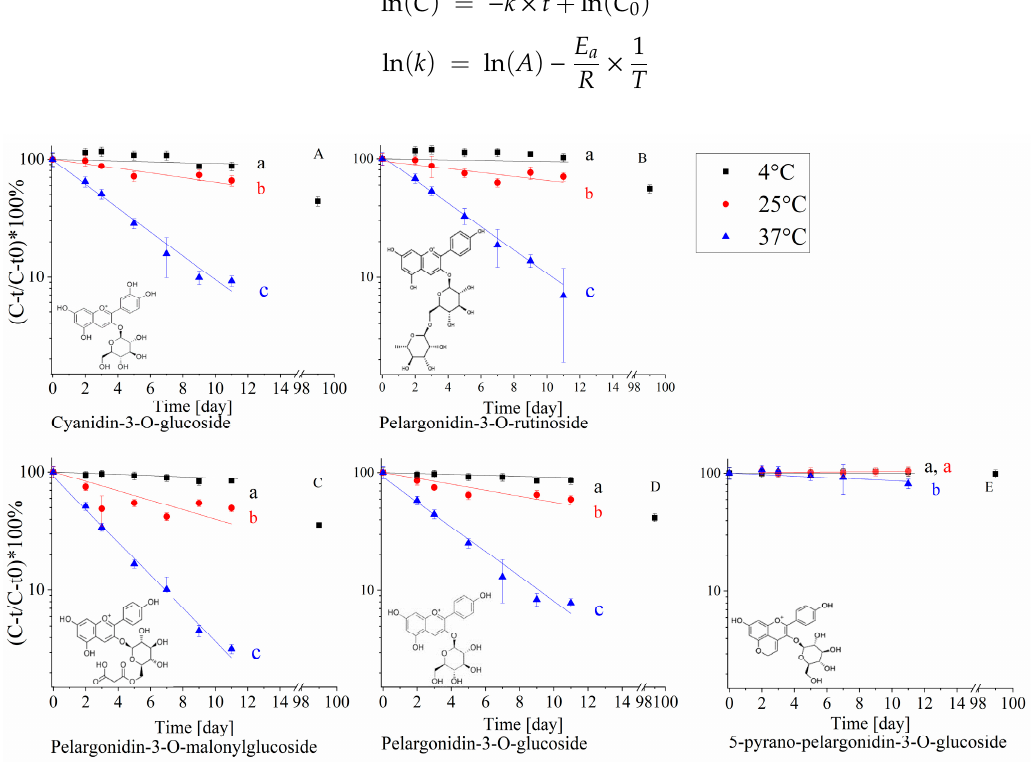
Figure 3. Relative concentration (quantified by HPLC at 520 nm) of the anthocyanins in the extract during shelf-life at different temperatures (4 °C, 25 °C and 37 °C, citric buffer pH = 3, 50 mM) ( A ) Cyanidin-3- O -glucoside, ( B ) Plargonidin-3- O -rutinoside, ( C ) Pelargonidin-3- O -malonylglucoside, ( D ) Pelargonidin-3- O -glucoside, ( E ) 5-Pyranopelargonidin-3- O -glucoside. * Error bars represent standard error (n = 2), the lines represent a fit to first-order kinetics. * Small letters near the regression line represent significant differences ( p < 0.05), according to the colors in the legend. Table 2. First order degradation rates ( k [1/day]) obtained during shelf-life experiment for the identified anthocyanins in the strawberry extract stored at 4 °C, 25 °C and 37 °C and their activation energies ( E a [KJ/mol]) (citric buffer pH = 3, 50 mM). k [1/day] E a [kJ/mol] Storage Temperature